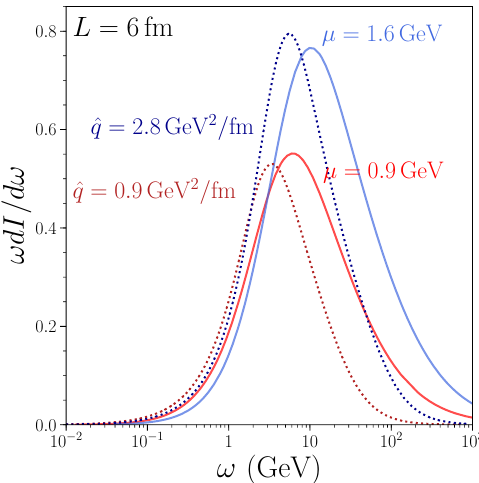
Figure 6 . Solid lines: full medium-induced gluon energy distribution for the Yukawa-type inter- action with (cid:22) = 1 : 6 GeV (blue) and (cid:22) = 0 : 9 GeV (red) for a medium with n 0 L = 5 and L = 6 fm as a function of the gluon energy ! . Dotted lines: medium-induced gluon energy distribution in the harmonic approximation for ^ q = 2 : 8 GeV 2 = fm (blue) and ^ q = 0 : 9 GeV 2 = fm (red) and L = 6 fm versus !